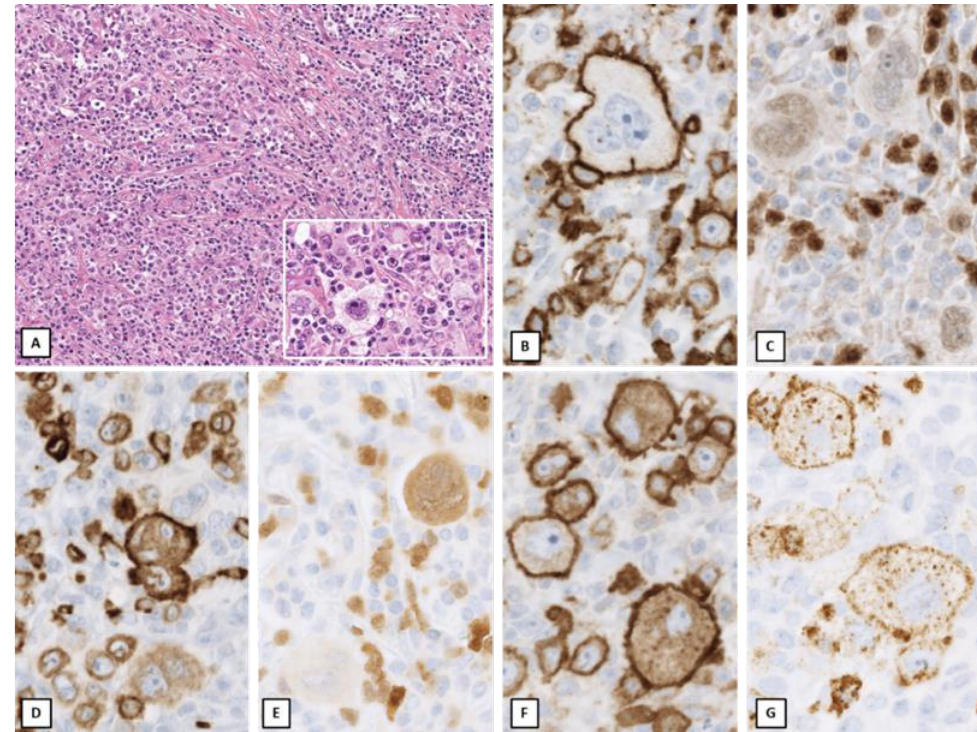
Figure 2. Non-mediastinal Grey Zone Lymphoma. Inguinal lymph node of a 48-year-old female patient. Architectural effacement with abundant pleomorphic HRS-like cells in a background of small lymphocytes, histiocytes and focal fibrosis (( A ); A inset). The large cells show positivity for CD20 ( B ), PAX5 ( C ), CD79a ( D ), BOB1 ( E ), CD30 ( F ), CD15 ( G ). The HRS-like morphology of the neoplastic cells with co-expression of B cell markers as well as CD30 and CD15 best fit with a diagnosis of non-mediastinal grey zone lymphoma, although these cases genotypically are distinct from mGZL (Original magnification: ( A ): × 100, A inset: × 400; ( B – G ): ×